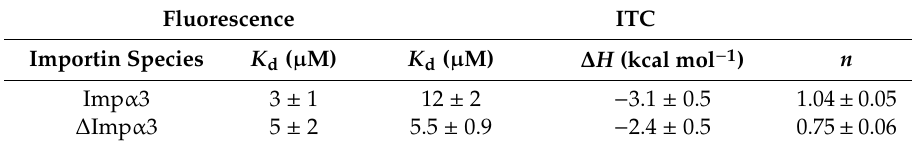
Table 1. Thermodynamic parameters at 298 K in the binding reaction of nuclear localization sequence (NLS)-NUPR1L to the two importin species. NUPR1, nuclear protein 1; ITC, isothermal titration